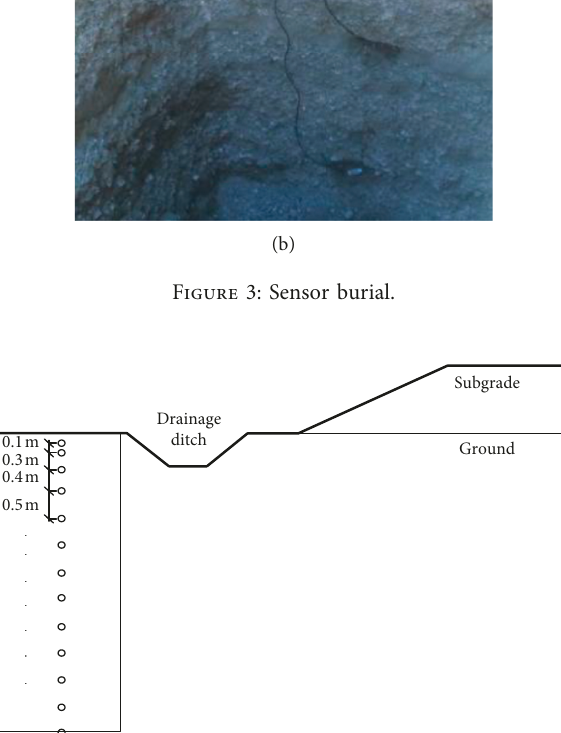
Figure 4: Typical section sensor layout